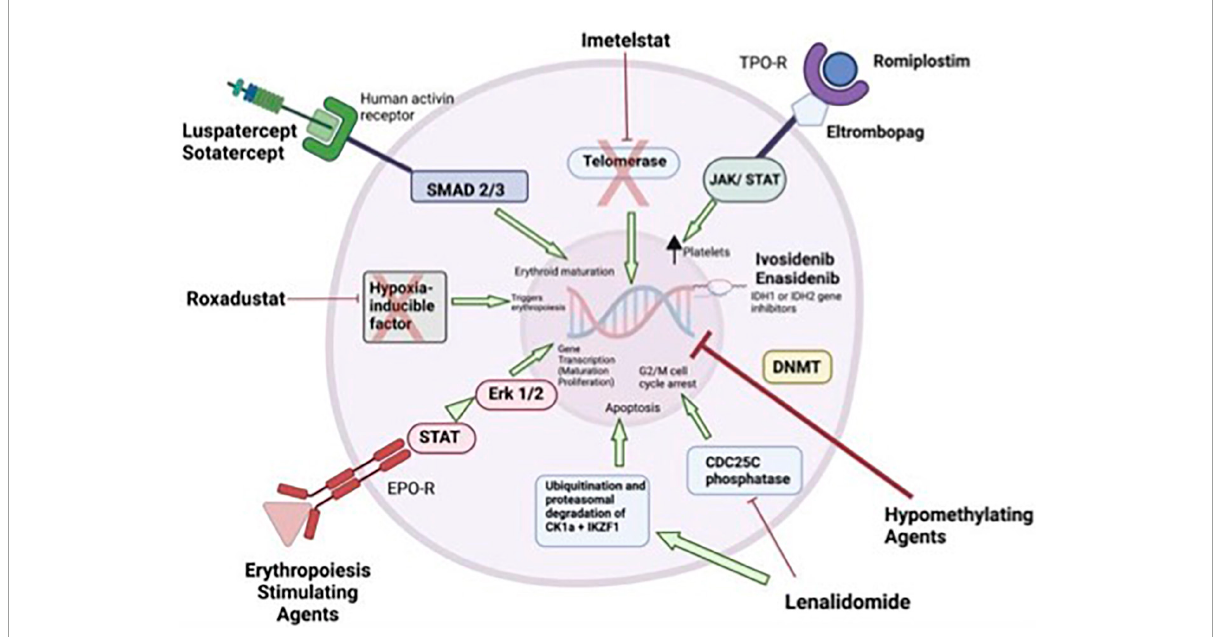
FIGURE1 Mechanism of actions for treatments in low-risk myelodysplastic syndromes (MDS). Erythropoiesis stimulating agents stimulate gene transcription of maturation and proliferation of erythrocytes through JAK/STAT and Erk1/2. Lenalidomide inhibits the CDC25C phosphatase and by decrease in CK1 α levels. Inhibition of the CDC25C phosphatase leads to a stoppage of proliferation by induction of an arrest in the cell cycle at the transition between G2 and M phase. Hypomethylating agents induce DNA hypomethylation. Ivosidenib, and enasidenib inhibits IDH1 or 1DH2 genes. Thrombopoietic receptor agonists activate signaling leads to increased platelet production. Imetelstat is a drug that help maintaining normal hematopoiesis by acting as a telomerase inhibitor in cells with short telomere length and hyper telomerase activity. “Luspatercept” and “sotatercept” specific activin receptor fusion proteins that act as ligand traps to neutralize negative regulators of late-stage erythropoiesis. Roxadustat is a small molecule that can be used orally and is an inhibitor of the “hypoxia-inducible factor” (20, 21, 61–64). EPO-R, erythropoietin receptor; JAK, janus kinase; STAT, signal transducer and activator of transcription; TPO-R, thrombopoietin